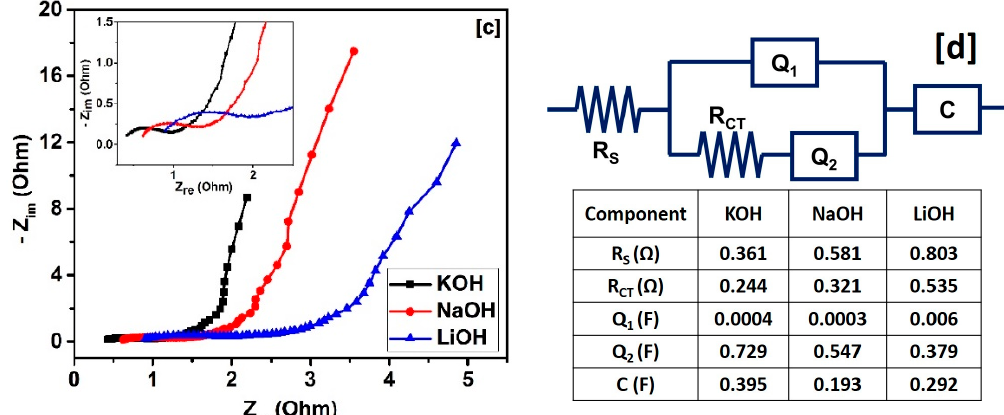
Figure 5. ( a ) Specific capacitances at different current densities, ( b ) specific capacitances at various scan rates, ( c ) Nyquist plots with inset displaying magnification at higher frequency region, and ( d ) equivalent circuit obtained from simulating the EIS data and fitting values for the components of the equivalent circuit for OPAC-1 electrode. Table 2. Comparison of the orange-peel-derived carbon to carbon derived from other biomass precursors. BET Surface Carbon Source